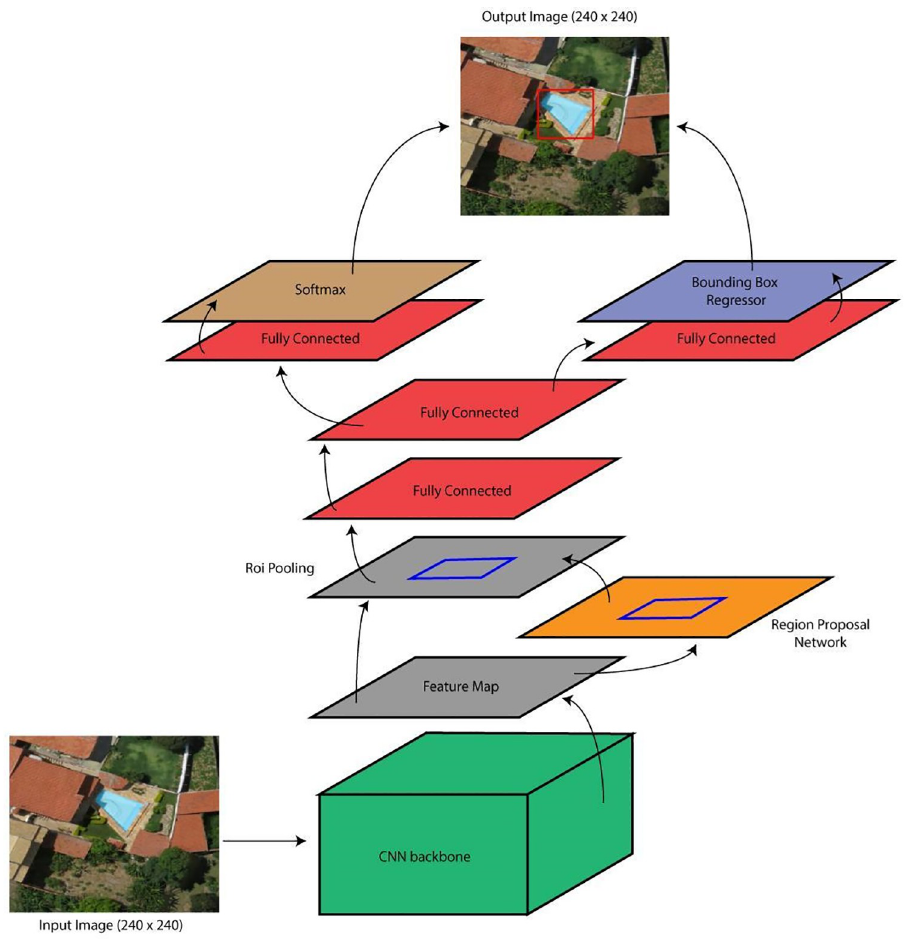
Fig 3. Faster R-CNN architecture pipeline illustration. Satellite images published under a CC BY license, with permission from G drones, original copyright 2016.